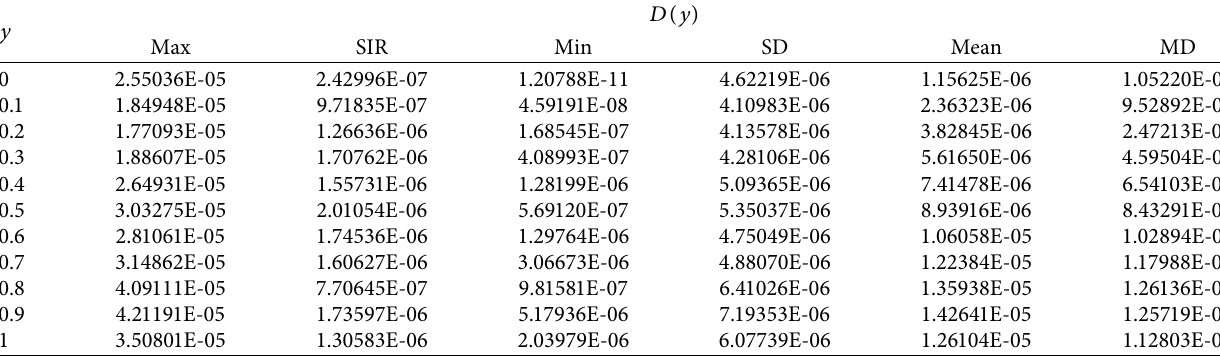
Table 7: Statistical performances for the class D ( y ) to solve the mathematical SEIR-NDC system.